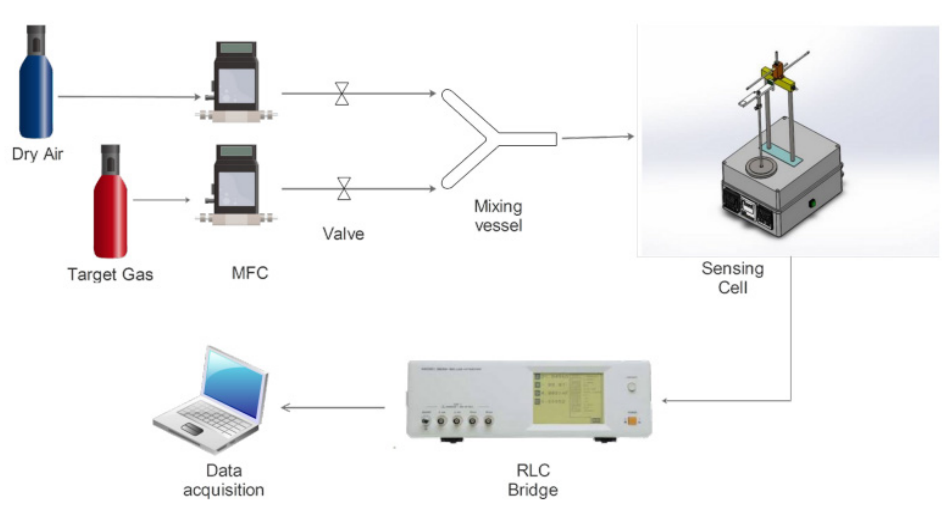
Figure 23. The gas sensing experimental setup used for micro-sensor measurements, from ref. [126].